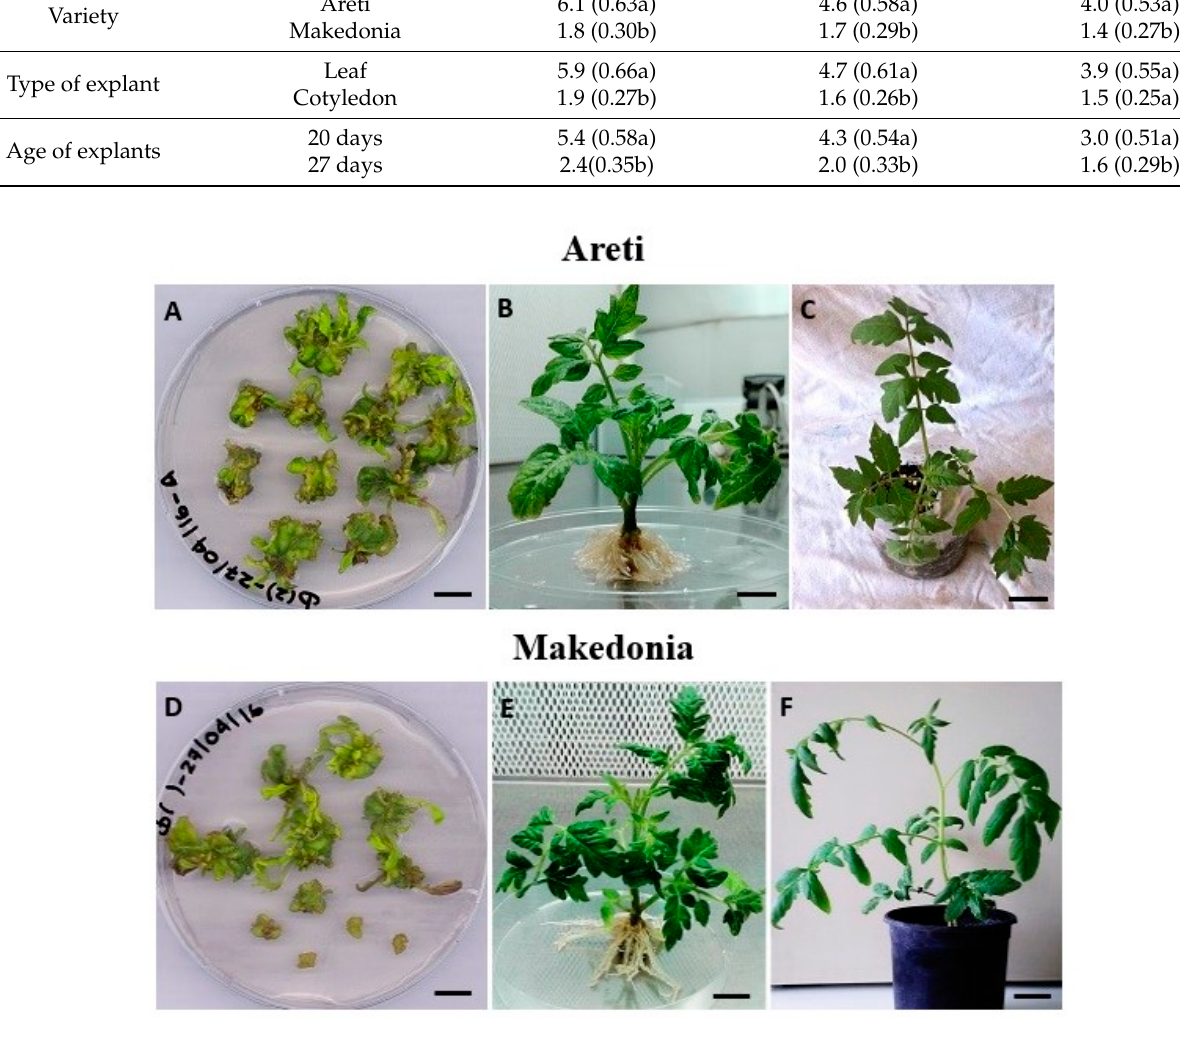
Figure 2. Regeneration, rooting, and acclimatization of var. Areti and Makedonia: ( A , D ) shoot regeneration of leaf explants on MSR3 and MSR1 media, respectively, bar = 2 mm; ( B , E ) rooting in MS supplemented with 1 mg · L − 1 IAA, bar = 11 mm; ( C , F ) successfully acclimatized plants, bar = 126 mm.